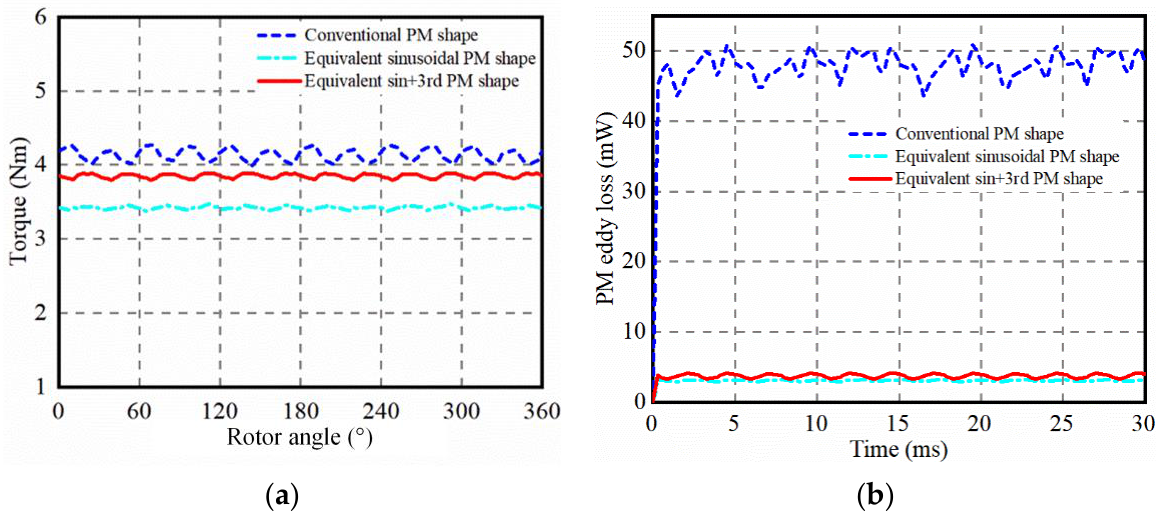
Figure 14. Comparison of motor performance parameters: ( a ) electromagnetic torque; ( b ) PM eddy current loss.